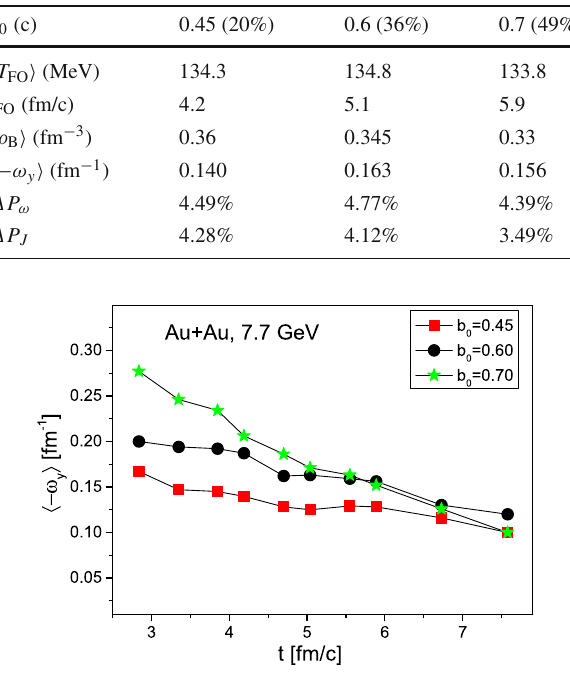
Fig. 6 The time evolution of average y -directed vorticity (cid:4)− ω y (cid:5) with different impact parameters in our model for Au+Au collisions at 7.7 GeV Table 2 The average freeze-out temperature T FO , freeze-out time t FO , averagevorticity (cid:4)− ω y (cid:5) ,and Δ P ω , Δ P J definedinEq.(15),